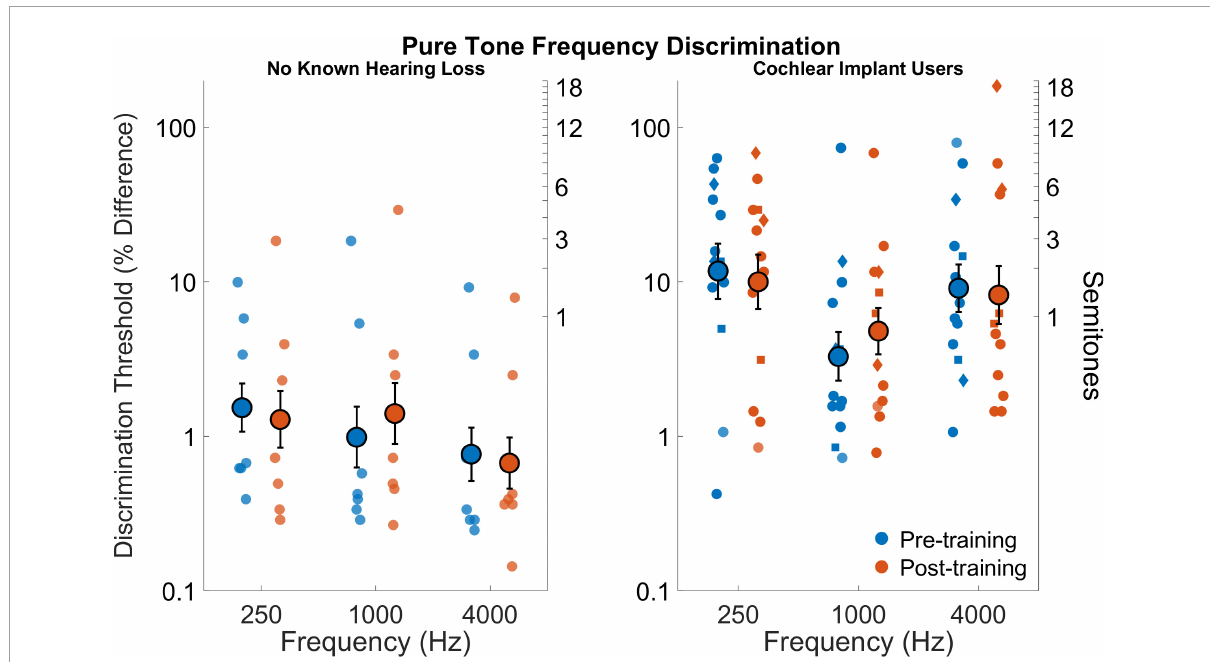
FIGURE3 Pure tone frequency discrimination thresholds as percent difference on logarithmic scale (left y axis) and semitones (right y axis) for frequencies 250, 1,000, and 4,000 Hz for participants with no known hearing loss (left subpanel) and for cochlear implant users (right subpanel). Smaller symbols indicate individual thresholds. Individual thresholds for cochlear implant users with implants from Cochlear Corporation are represented with a circle, Advanced Bionics with a diamond, and MED-EL with a square. Larger circles indicate group averages for each session with error bars indicating standard errors of the